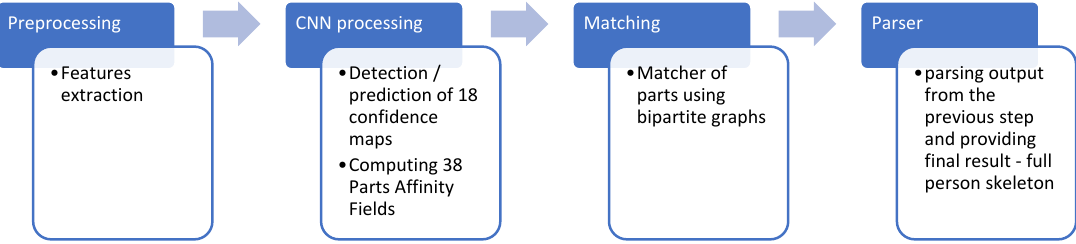
Figure 10. OpenPose stages for human pose detection.